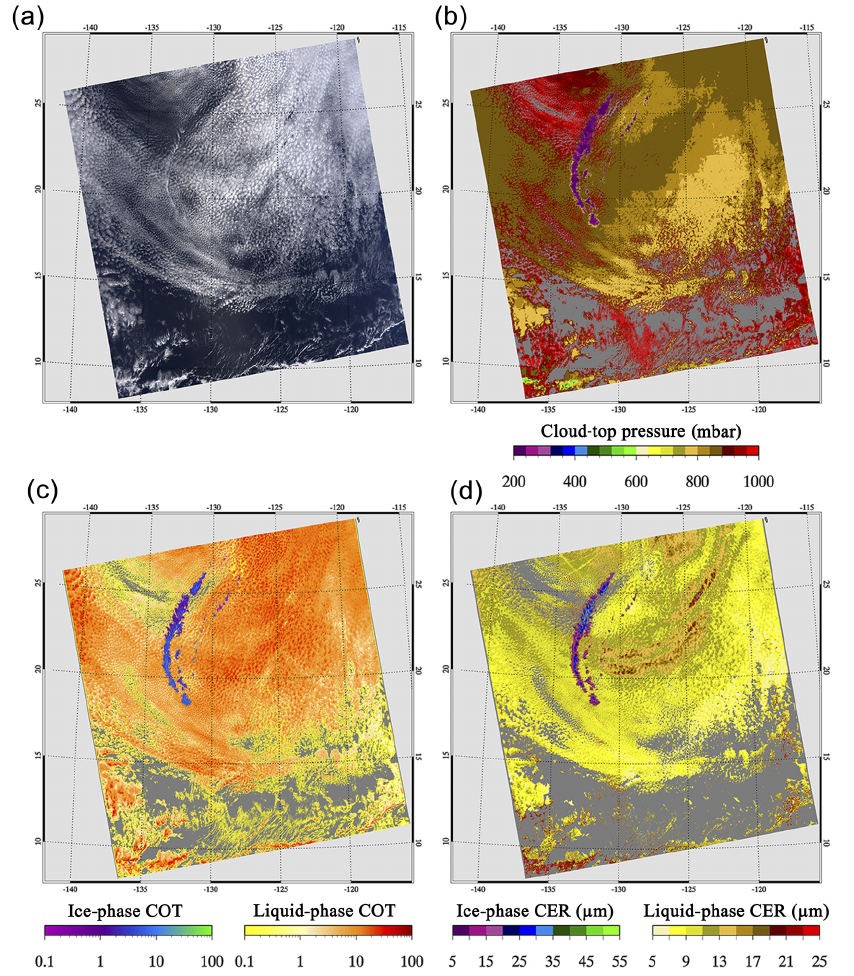
Figure 5. (a) True color image, C6 (b) 1km CTP, (c) cloud optical thickness, and (d) 2.1µm effective radius for a MODIS–Aqua granule acquired off the coast of Baja California on 9 June 2014